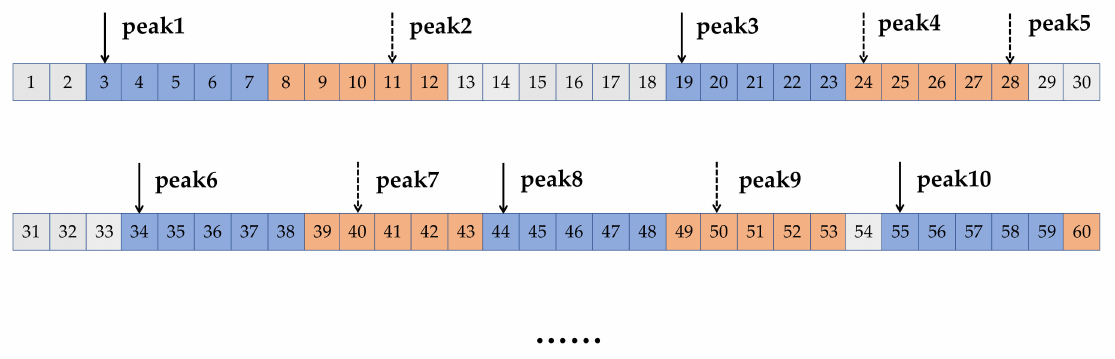
Figure 4. Examples of data segmenting of the recorded ECG. The time-leading parts are displayed in blue and the time-lagged part are displayed in orange. The elements between the time-leading parts and the time-lagged parts (grey) are